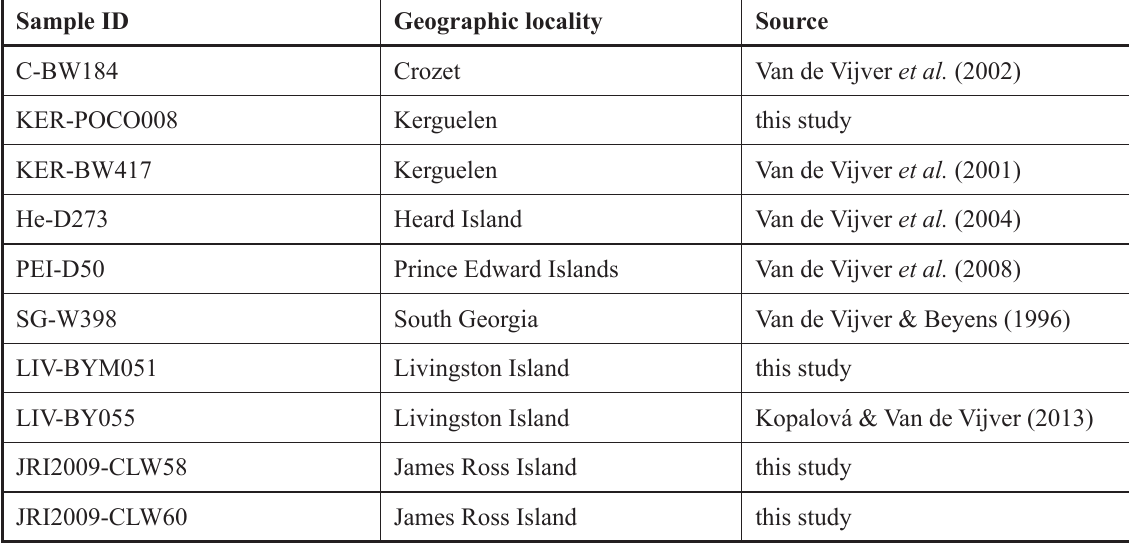
Fig. 1. The Antarctic region with the location of the sampled islands and archipelagos. Table1. List of samples used in this